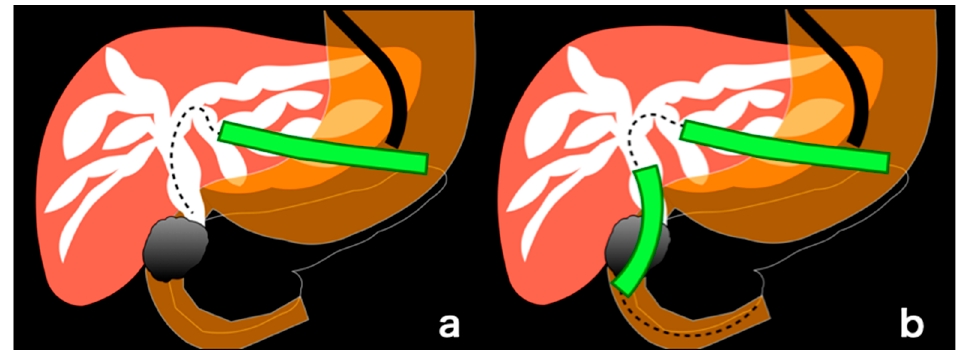
Figure 1. ( a ). Schematic drawing of endoscopic ultrasound-guided hepaticogastrostomy (EUS-HGS); In EUS-HGS, one stent (green) is placed transgastrointestinal. ( b ). Schematic drawing of EUS-guided antegrade stenting (EUS-AS) combined with EUS-HGS (EUS-HGAS); In EUS-HGAS, two stents (green), transgastrointestinal and transpapillary, are placed.